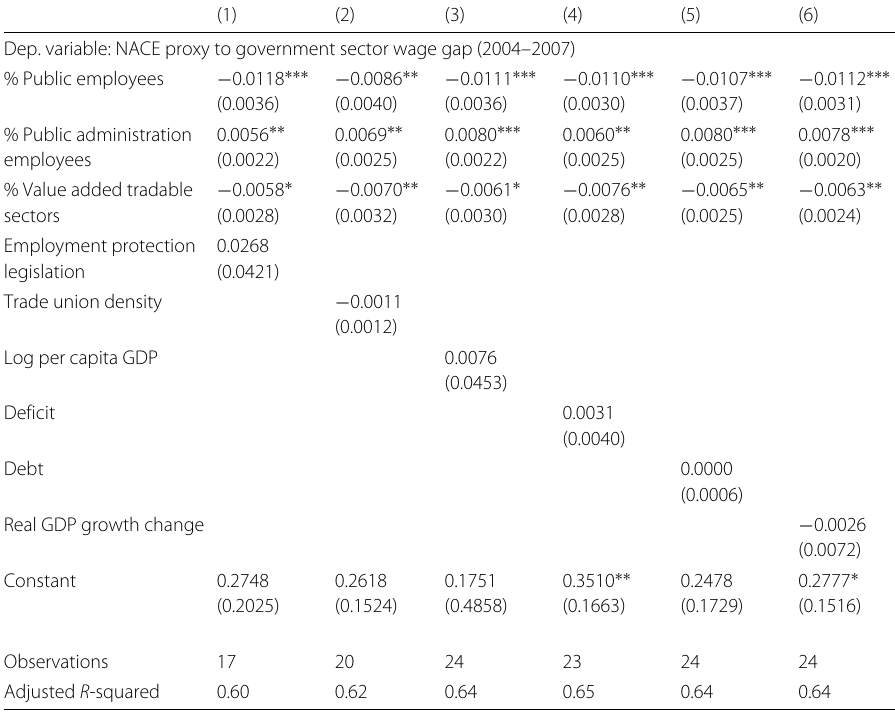
Table 10 Determinants of the public sector pay gap: sample 2004–2007